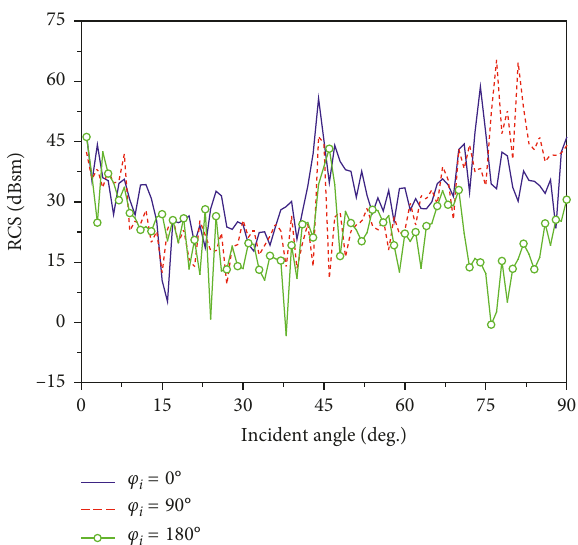
Figure 12: The change of RCS of the ship with incident angle at different incident planes.